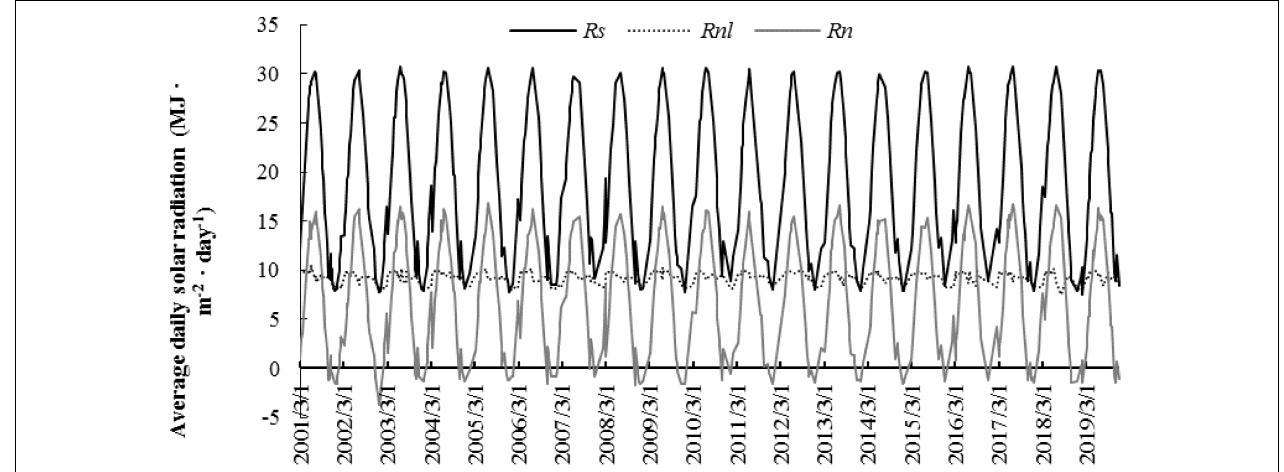
FIGURE 8 | The average values of daily solar incident radiation ( Rs ), daily long-wave net radiation ( Rnl ), and daily net radiation ( Rn ) under clear-sky conditions from 2001 ∼ 2019 in the Haihe River